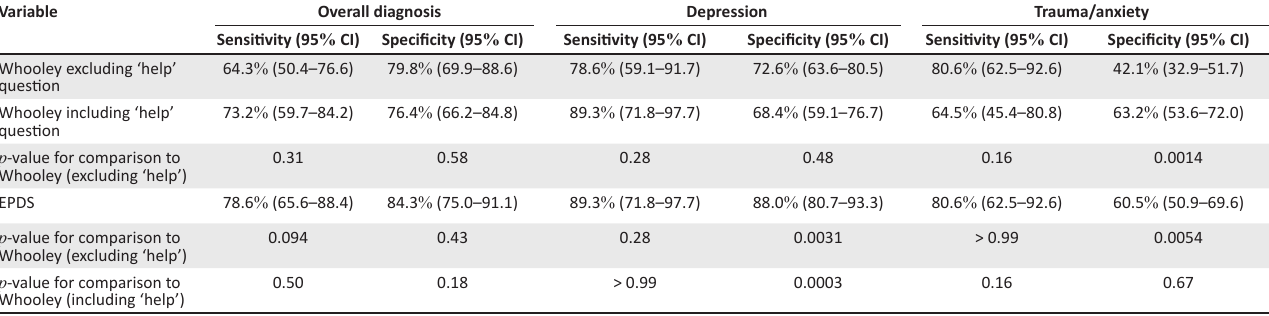
TABLE 3a: Comparison of screening tools, sensitivity and specificity, with confidence intervals. Variable